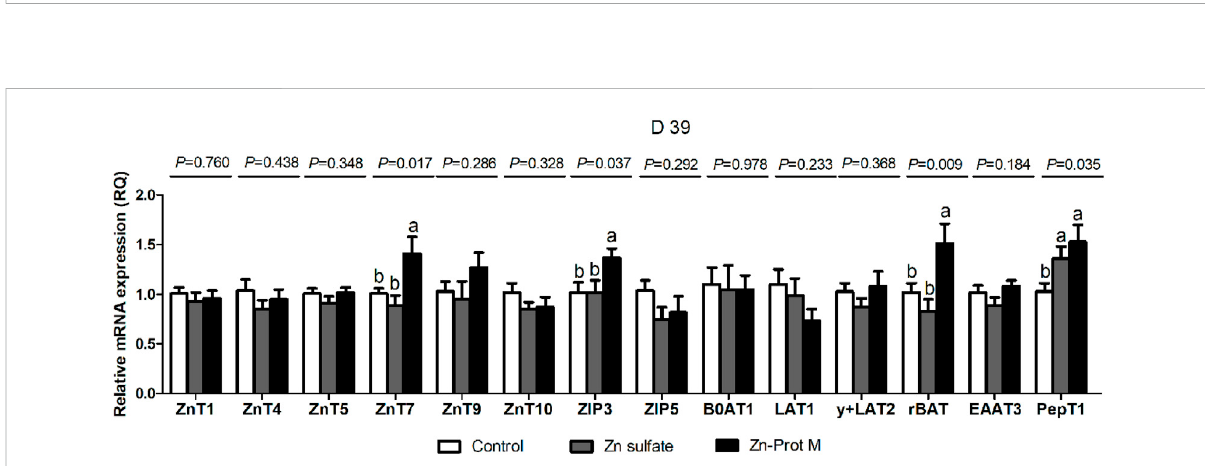
FIGURE 2 Effect of dietary Zn source on the mRNA expression levels of Zn, amino acid, and small peptide transporters in the duodenum of broilers at 39 days of age. Values are means ± SE, (n = 7/8). Lacking the same letters (a and b) means signi fi cant differences, p < 0.05. ZnT1, zinc transporter 1; ZnT4, zinc transporter 4; ZnT5, zinc transporter 5; ZnT7, zinc transporter 7; ZnT9, zinc transporter 9; ZIP3, Zrt-irt-like protein 3; ZIP5, Zrt-irt-like protein 5; B0AT1, B-0-system neutral amino acid co-transporter; LAT1, L-type amino acid transporter 1; y + LAT2, y + L-type amino acid transporter 2; rBAT, b0,+-type amino acid transporter; EAAT3, excitatory amino acid transporter 3; PepT1, peptide-transporter 1; Zn-Prot M, Zn proteinate with moderate chelation strength (Q f = 51.6). The mRNA expression levels were calculated as the relative quantities (RQs) of the target gene mRNA to the geometric mean of β -actin and GAPDH mRNA using the 2 − ΔΔ CT